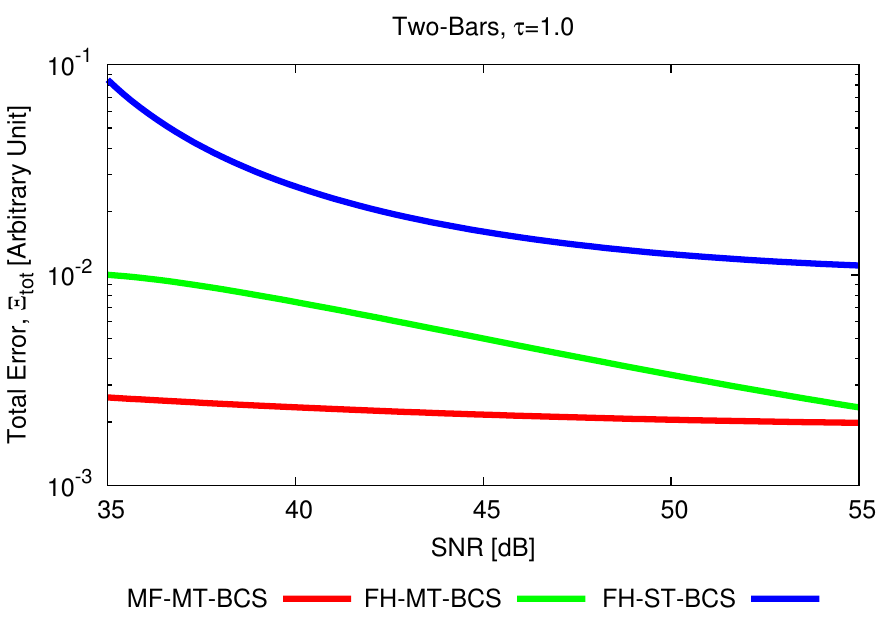
Figure 3. Numerical assessment ( “Two-Bars” Scatterer , τ = 1.0, N = 400, SNR ∈ [ 35, 55 ] dB)—Behavior of the total integral error as a function of the SNR on time-domain total field for the MF-MT-BCS , FH-MT-BCS , and FH-ST-BCS methods.